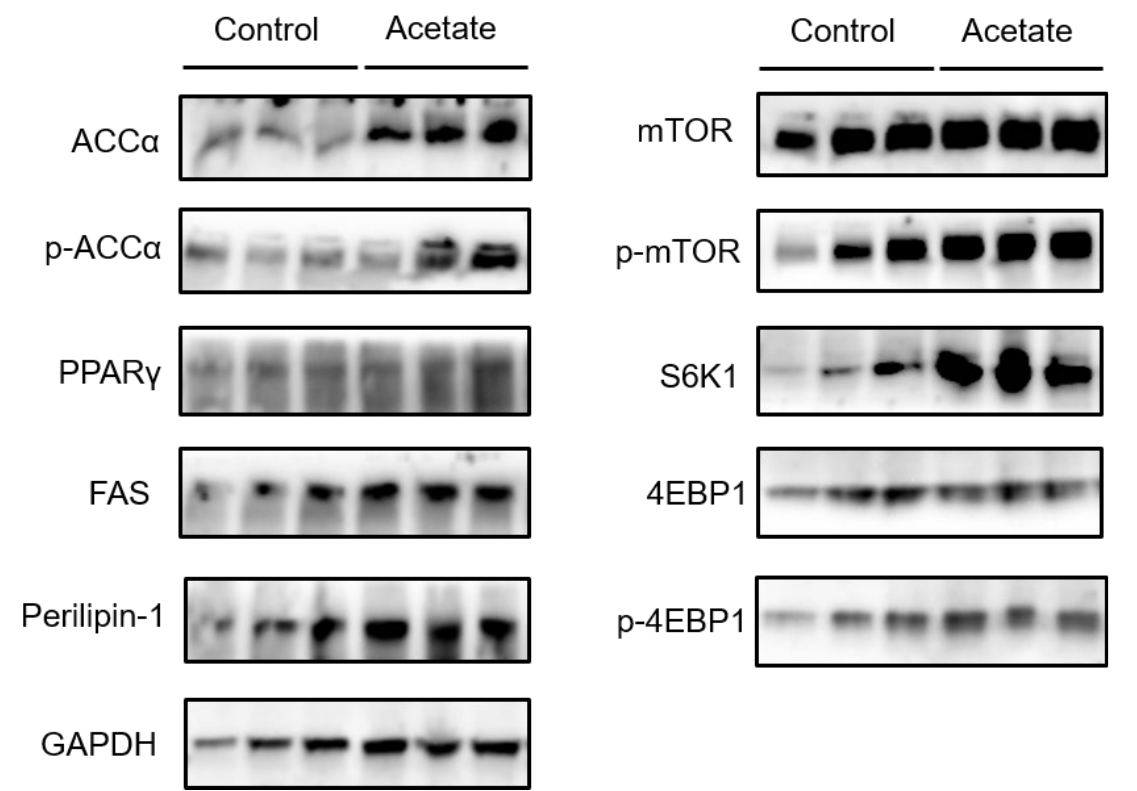
Figure 4. Effects of acetate on the expression of key proteins involved in the mTOR signaling pathway and lipid metabolism. Bovine mammary epithelial cells were exposed to either 0 (as a control group) or 12 mM acetate for a protein expression analysis. Western blotting analysis of mTOR, p-mTOR, S6K1, 4EBP1, p-4EBP1, ACC α , p-ACC α , FAS, perilipin-1, and PPAR γ . The data were based on triplicate experiments.